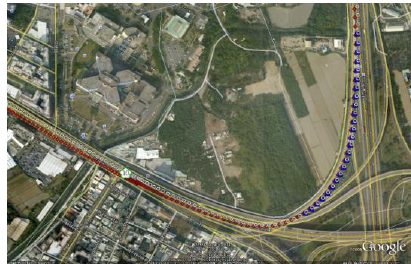
Figure 5 The comparison between TC and LC architectures in urban